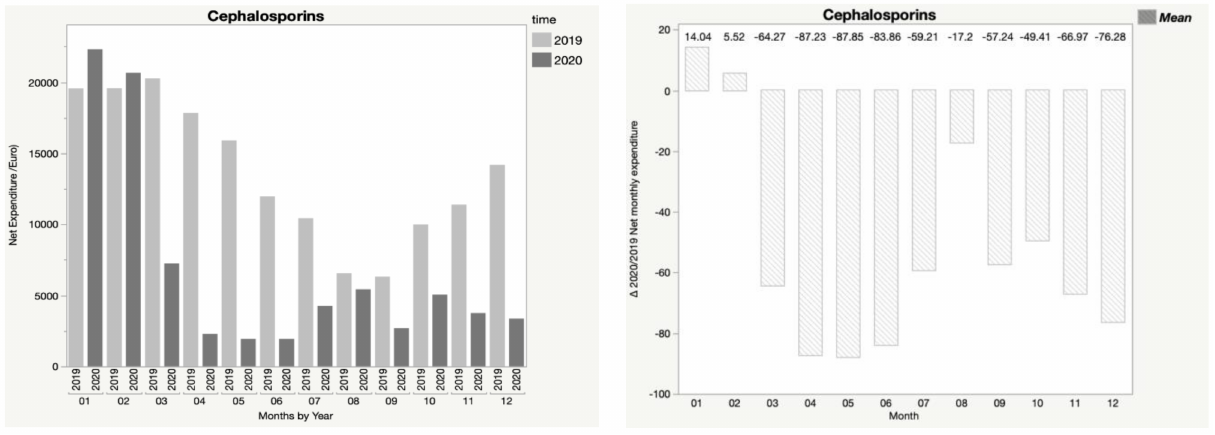
Figure 2. Trend in net expenditure (EUR) and delta 2020/2019 of net monthly expenditure of cephalosporin from January